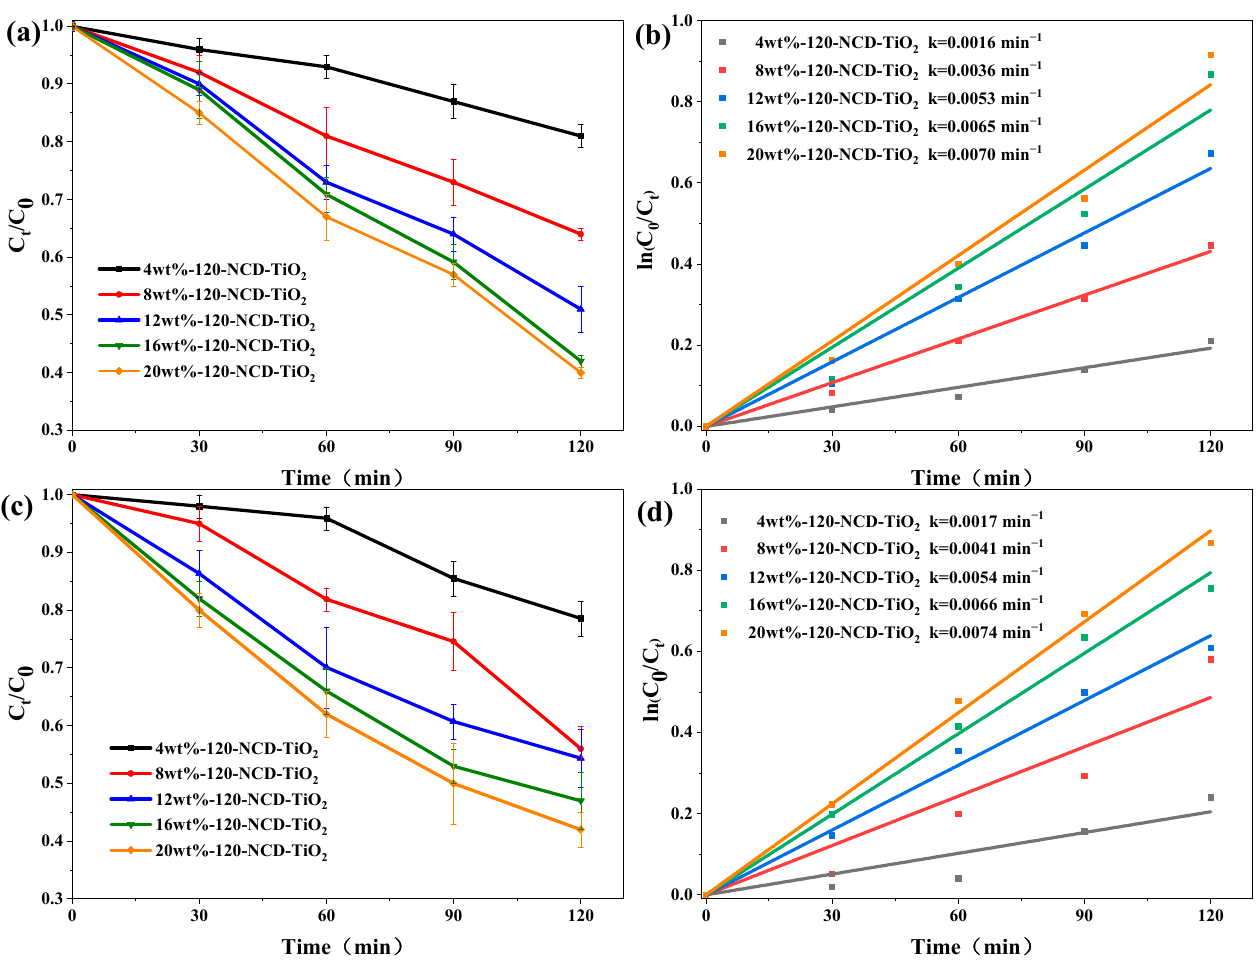
Figure 6. Photocatalytic activities of PVA/NCD-TiO 2 nanocomposite films with various concentra- tions of NCD-TiO 2 on the degradation of phenol ( a , b ) and LEV ( c , d ) under visible-light irradiation.